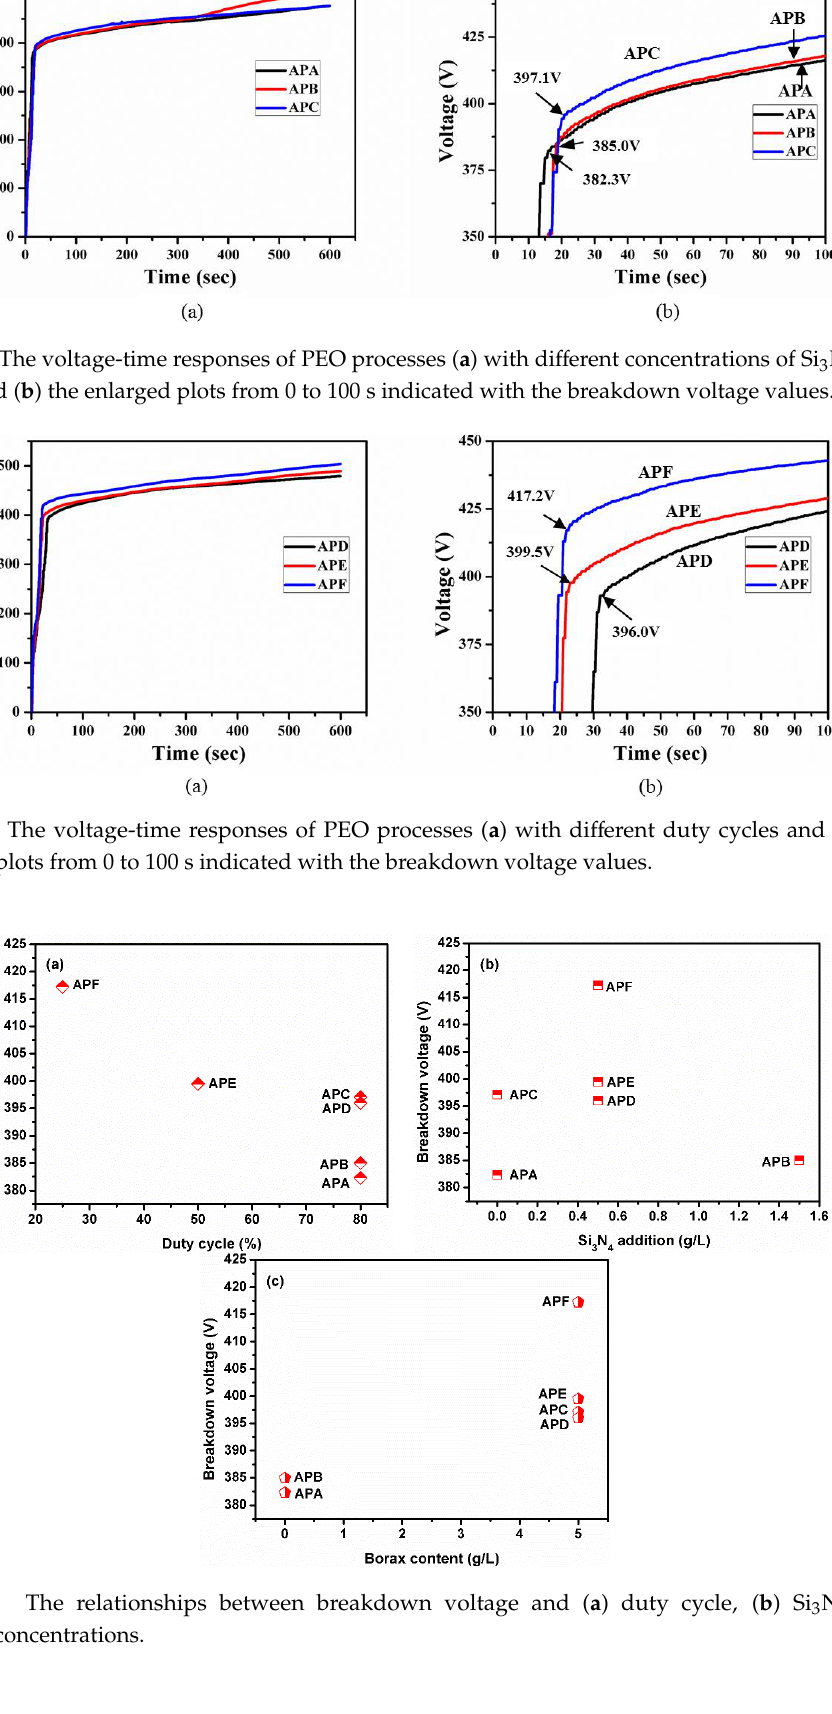
Figure 3. The relationships between breakdown voltage and ( a ) duty cycle, ( b ) Si 3 N 4 and ( c ) borax concentrations.